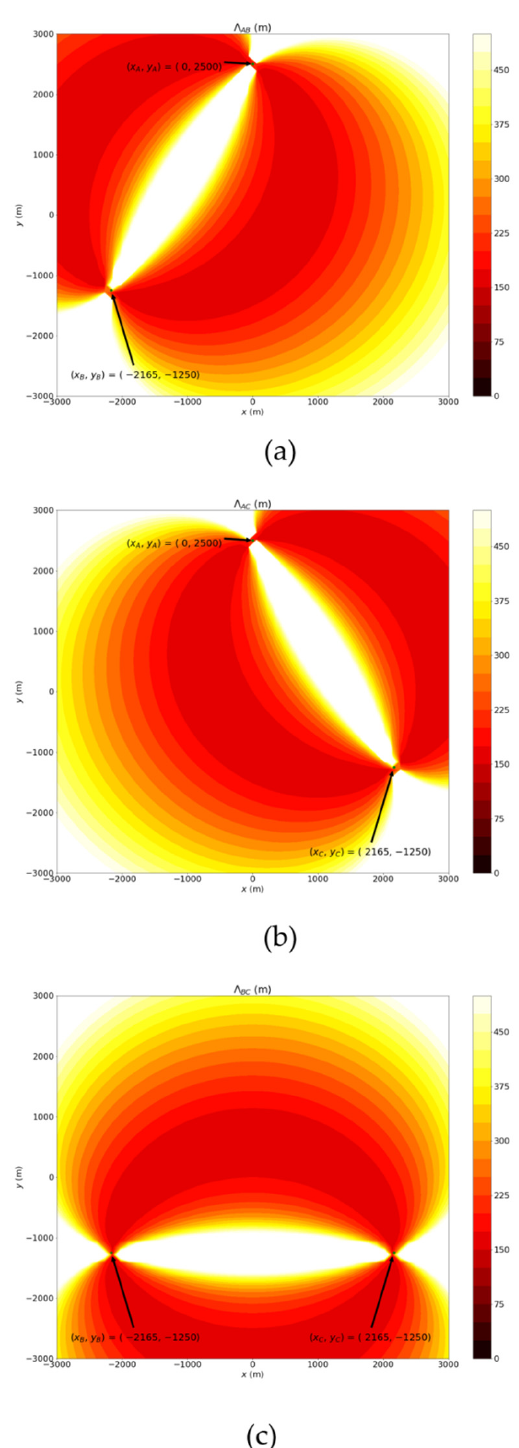
Figure 5. The example distributions of ( a ) Λ AB ( b ) Λ AC ( c ) Λ BC